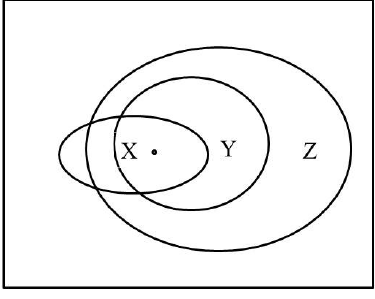
Fig. 2. Illustration of the rule (SUBST).